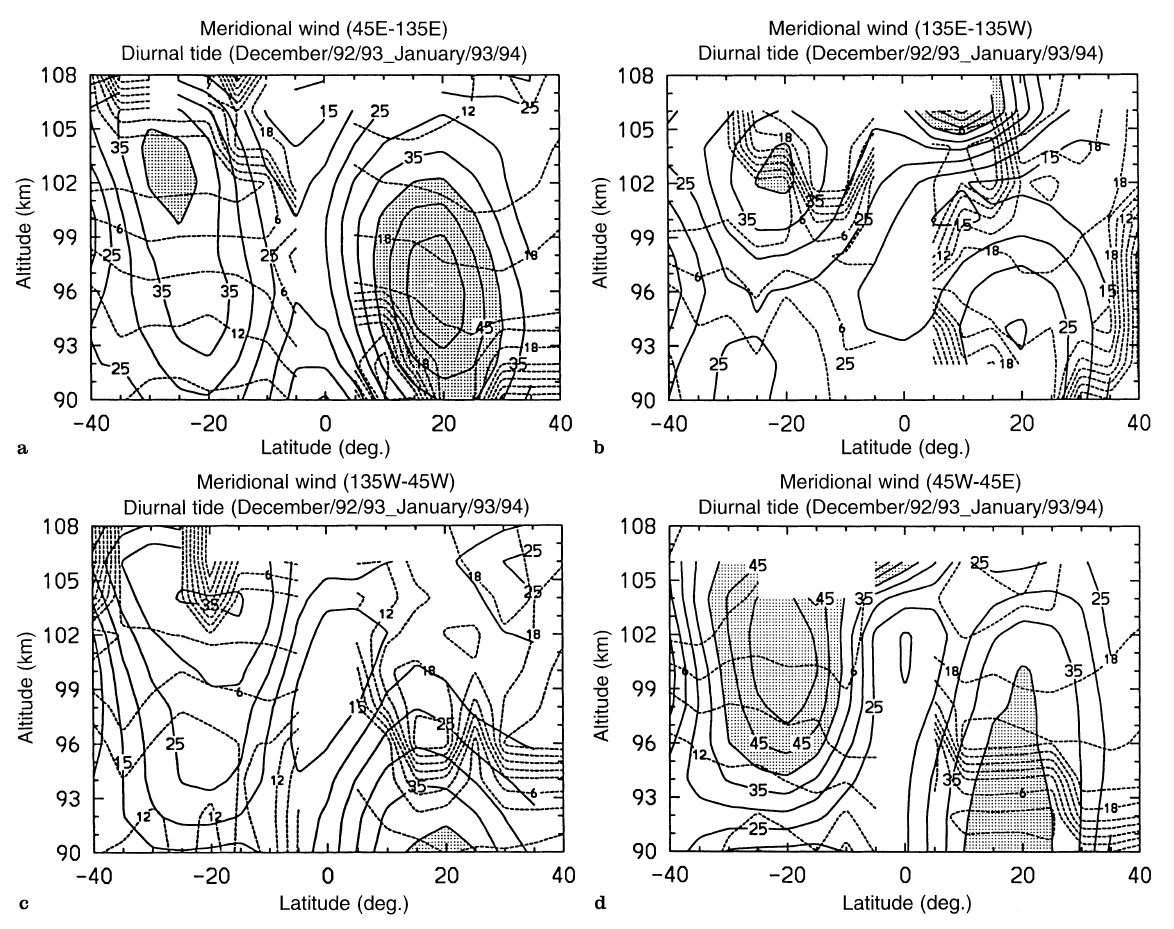
Fig. 2a–d. Contours of meridional wind amplitude ( solid lines ) and phase ( dashed lines ) of the diurnal tide observed by WINDII for December 1992, 1993 and January 1993, 1994 at: a 45 (cid:176) E to 135 (cid:176) E,